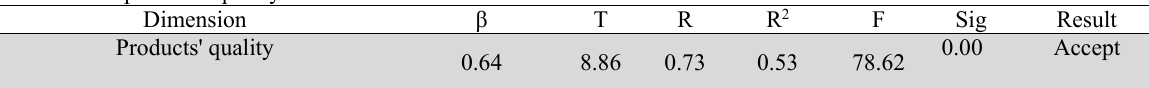
Results of test products' quality on brand